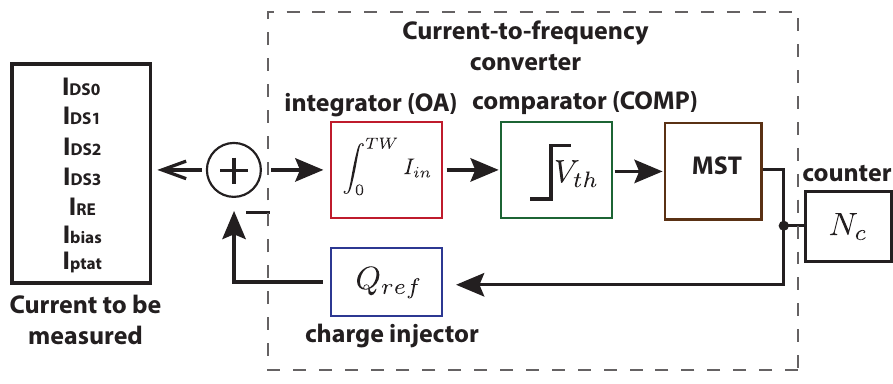
Figure 4. CFC and the different currents to be